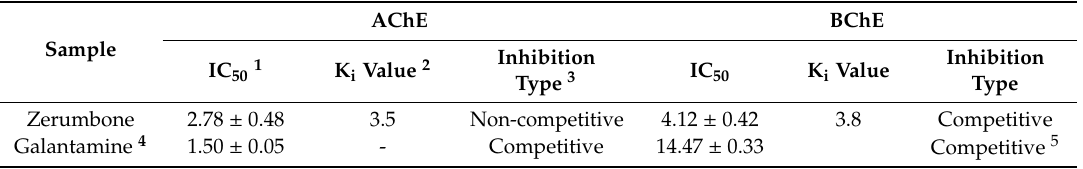
Figure 1. The chemical structure of zerumbone. Table 1. Cholinesterases inhibitory activities, inhibition type, and dissociation constants (Ki) of zerumbone.